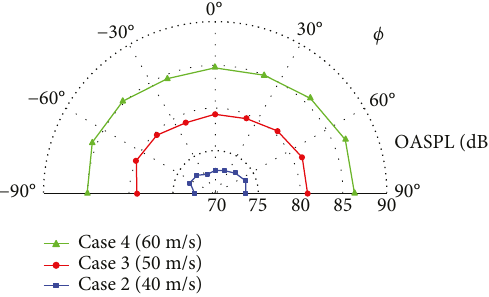
Figure 7: A-weighted directivity performance of the cavity at di ff erent main fl ow speeds.